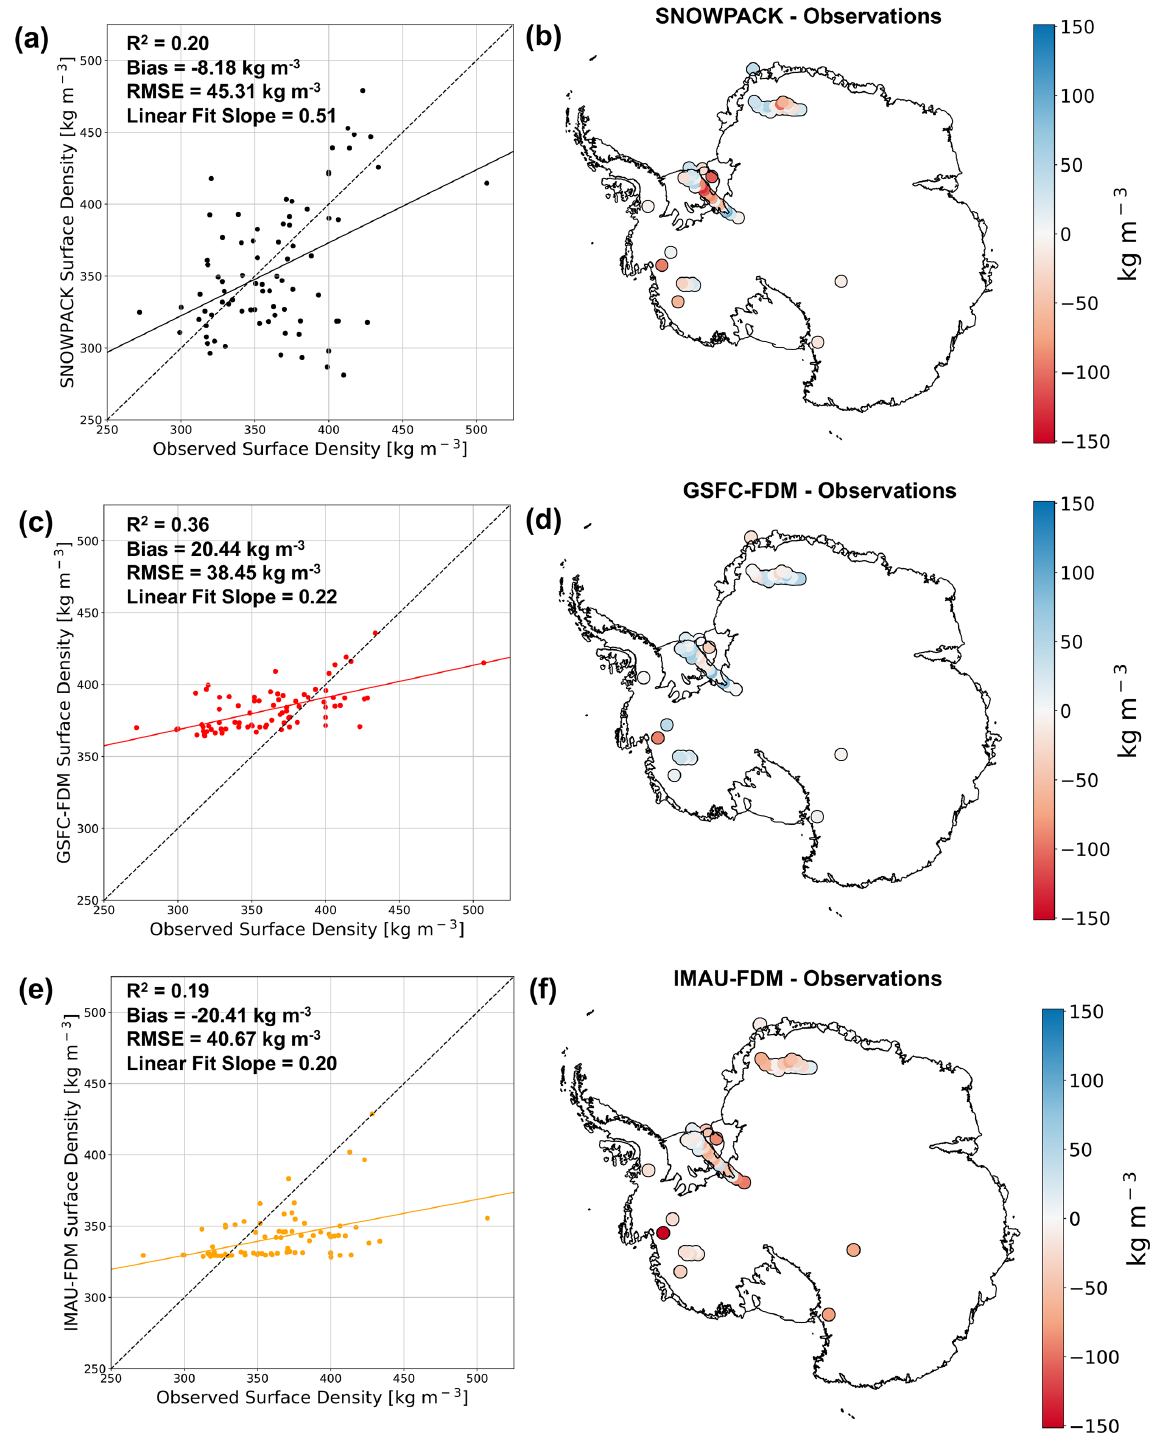
Figure 7. Modeled and observed surface density comparison. Scatter plots of observed vs. SNOWPACK-modeled (a) , GSFC-FDM-modeled (c) , and IMAU-FDM-modeled (e) surface density at 79 locations across the AIS. Maps of SNOWPACK (b) , GSFC-FDM (d) , and IMAU- FDM (f) minus observed surface density at 79 locations across the AIS. In (a) , (c) , and (e) , dashed black lines represent one-to-one lines while solid lines represent linear